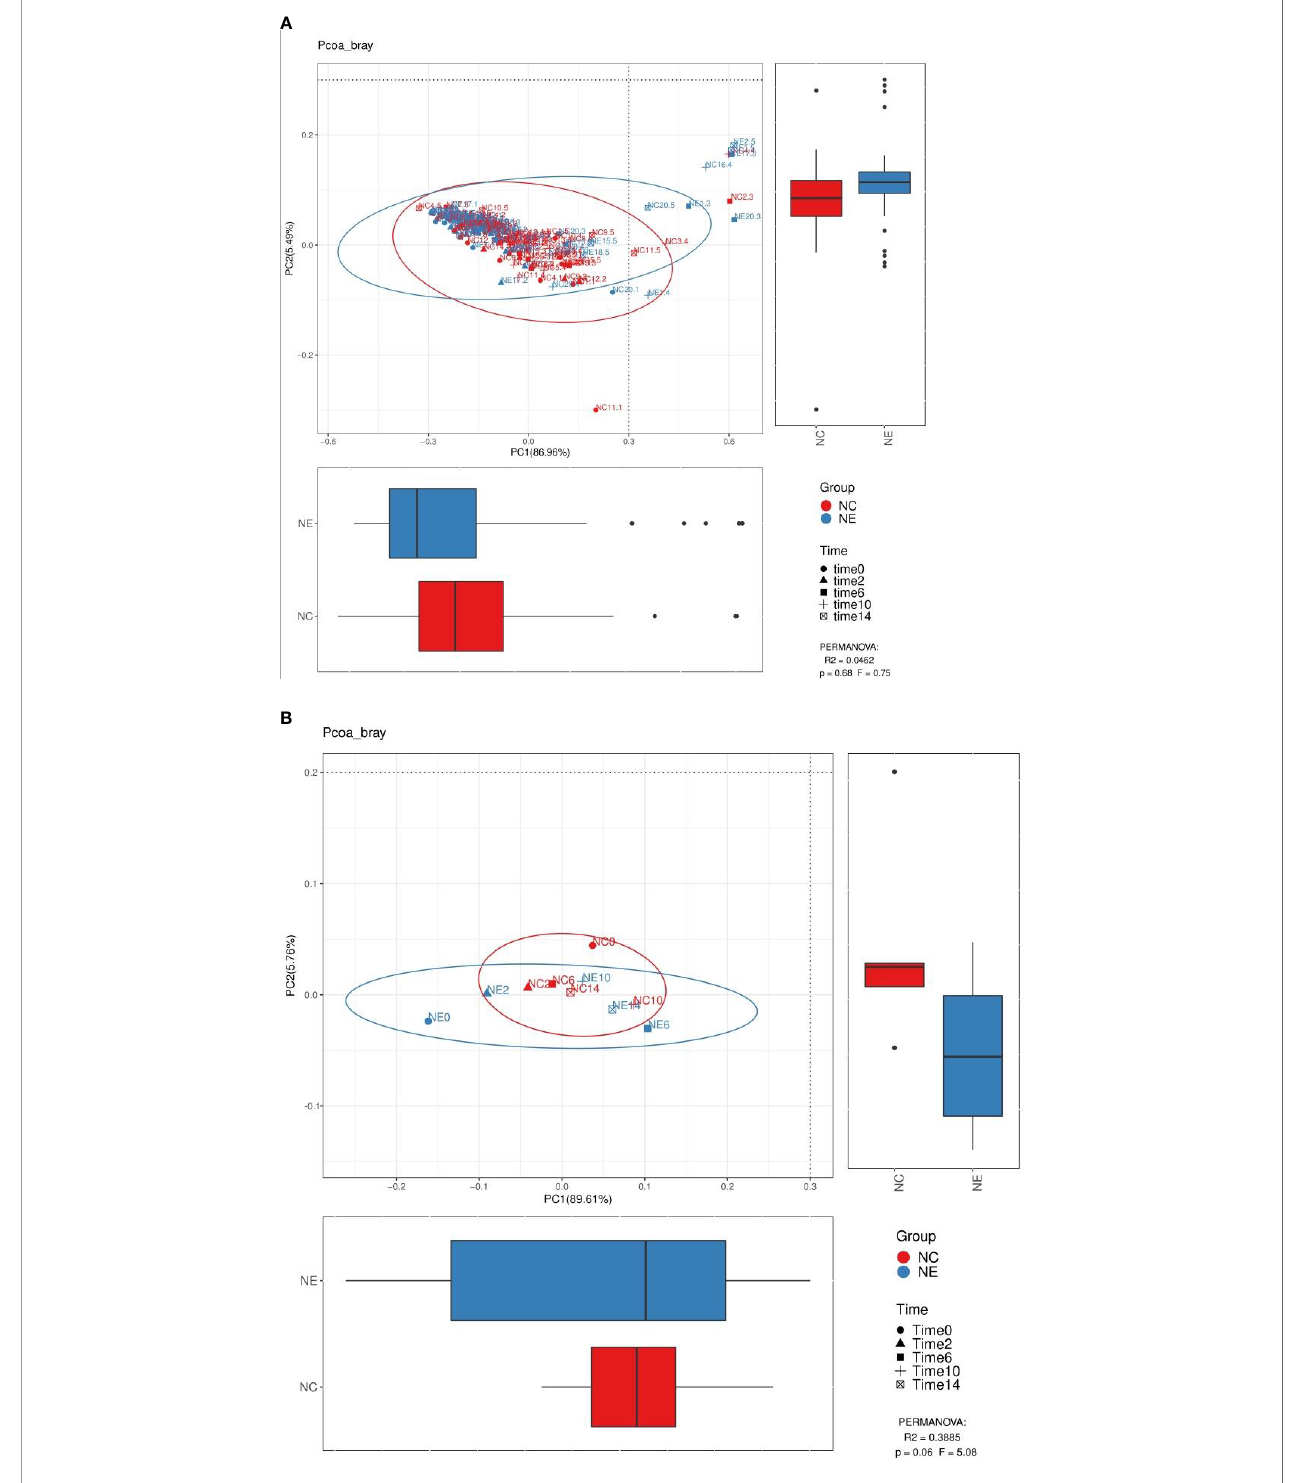
FIGURE 8 | Analysis diagram of principal coordinate analysis (PCoA) at the phylum level. We performed PCoA analysis based on Bray-Curtis distance. Each point in (A) represents a sample, and each point in (B) represents the average of 15 samples at a point in time. The points of the same color come from the same group, and the distance re fl ects the similarity of the samples. We used PERMANOVA test to analyze the signi fi cance, p value and the F value are at the bottom right of the graph. The red represents the NC group and the blue represents the NE